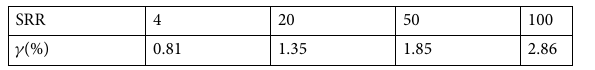
Table 2. The error indexes corresponding to the different SRRs.